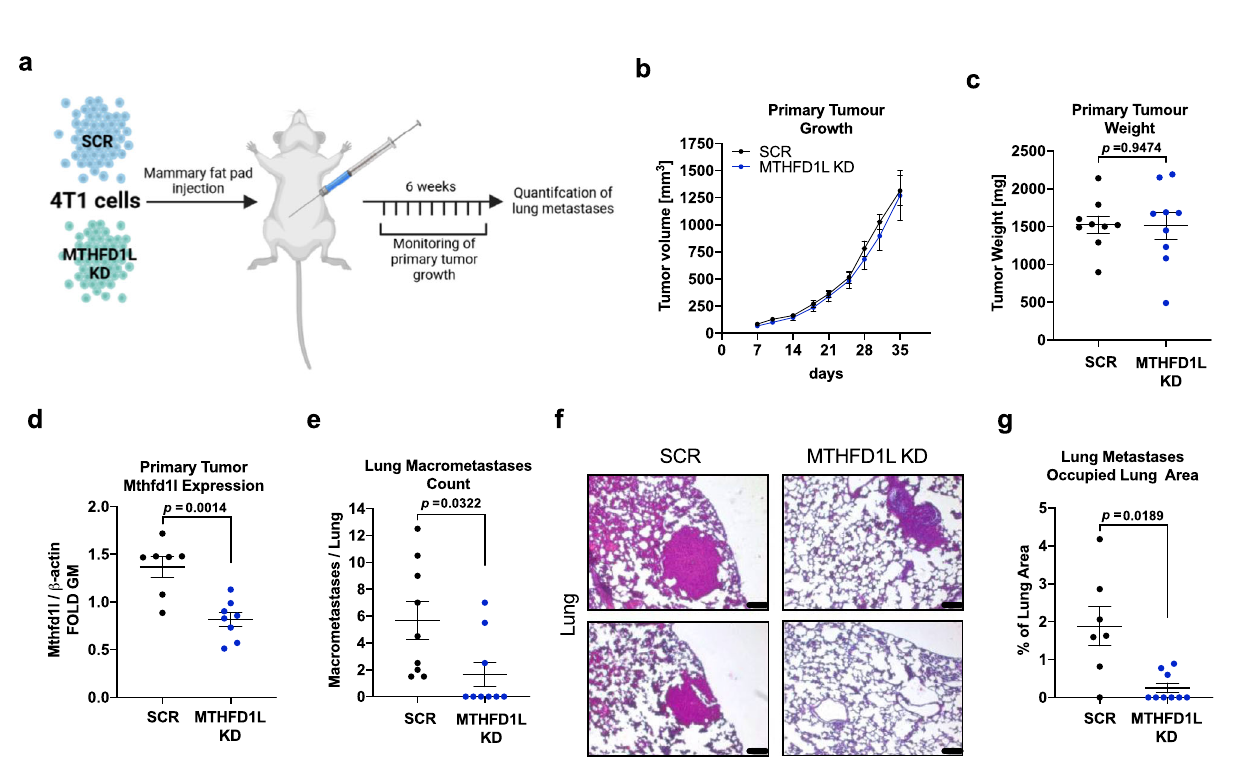
Fig. 7 Genetic targeting of mitochondrial 1C metabolism reduces metastasis formation in vivo. a 4T1 breast cancer cells transfected with non-targeting control (SCR, n = 9) and 4T1 cells with KD of Mthfd1l ( n = 9) were injected into the mammary fat pads of immunocompetent female Balb/c mice. Primary tumor growth was monitored and lung metastasis formation was evaluated at end-point. b Primary tumor size was measured and mean tumor volume for each group was calculated; mean ± SEM ( n = 8 (Scr) and 9 (Mthfd1l KD)). c Primary tumor weight was measured at the end-point. Dots indicate individual animals; mean ± SEM ( n = 9); unpaired, two-tailed t -test with Welch ’ s correction. d Primary tumor tissue was analyzed for Mthfd1l protein expression by Western Blot and quanti fi ed relative to β -actin as loading control. Dots indicate individual animals; mean ± SEM ( n = 7 (Scr) and 8 (Mthfd1l KD)); unpaired, two-tailed t -test with Welch ’ s correction. Protein lysates from tumors with signi fi cantly low Mthfd1l and β -actin expression relative to total protein were judged to be not pure tumor lysate and discarded from analysis (see Figure S7D – F for details). e Macroscopic lung metastases were counted and are depicted as number of metastases per lung. Dots indicate individual animals; mean ± SEM ( n = 9); unpaired, two-tailed t-test with Welch ’ s correction. f Lung tissue was embedded in paraf fi n and stained with H&E. 2 representative images per group are presented to show microscopic lung metastasis; scale bar corresponds to 100 μ m. g Metastatic area per lung was quanti fi ed and is expressed as % area of lung tissue. Dots indicate individual animals; mean ± SEM ( n = 7 (Scr) and 9 (Mthf1l KD)); unpaired, two-tailed t -test with Welch ’ s correction. Source data are provided as a Source Data fi